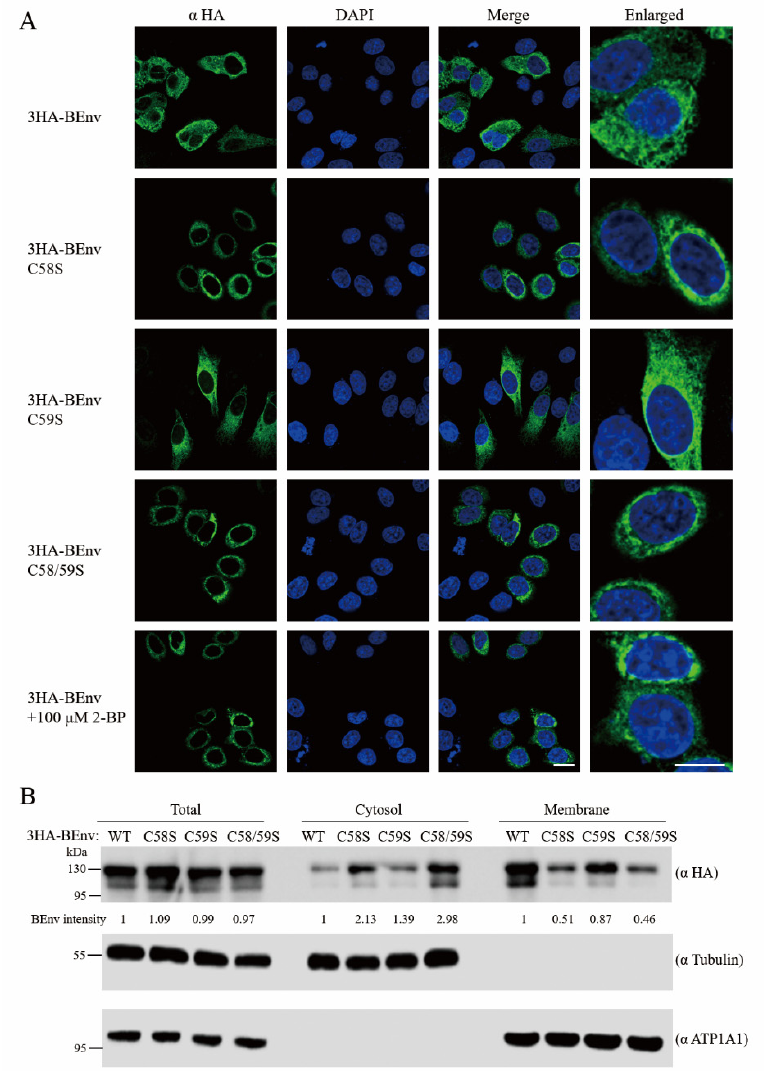
Figure 6. ( A ) Palmitoylation is required for trafficking of BEnv to the cell surface. HeLa cells were transfected with either wild type or palmitoylation mutant 3HA-BEnv. Cells transfected with wild type BEnv were treated with 100 µM 2-BP for 6 h before being assayed. Twenty-four hours post-transfection, the cells were subjected to immunofluorescence for detection of BEnv using the mouse anti-HA antibody. The nuclei were stained with DAPI. The subcellular localization of BEnv was analyzed by confocal laser scanning microscopy. Scale bars represent 10 µm. ( B ) HEK293T cells were transfected with either wild type 3HA-BEnv or its mutants (C58S, C59S, and C58/59S). After 48 h, cells were collected, the membrane and cytosol fractions were prepared as described in the Materials and methods. Each fraction was examined by Western blotting to measure the levels of BEnv. Tubulin and ATP1A1 were probed as markers for the cytosol and plasma membrane, re- spectively. Intensity of protein bands was determined with Image J.